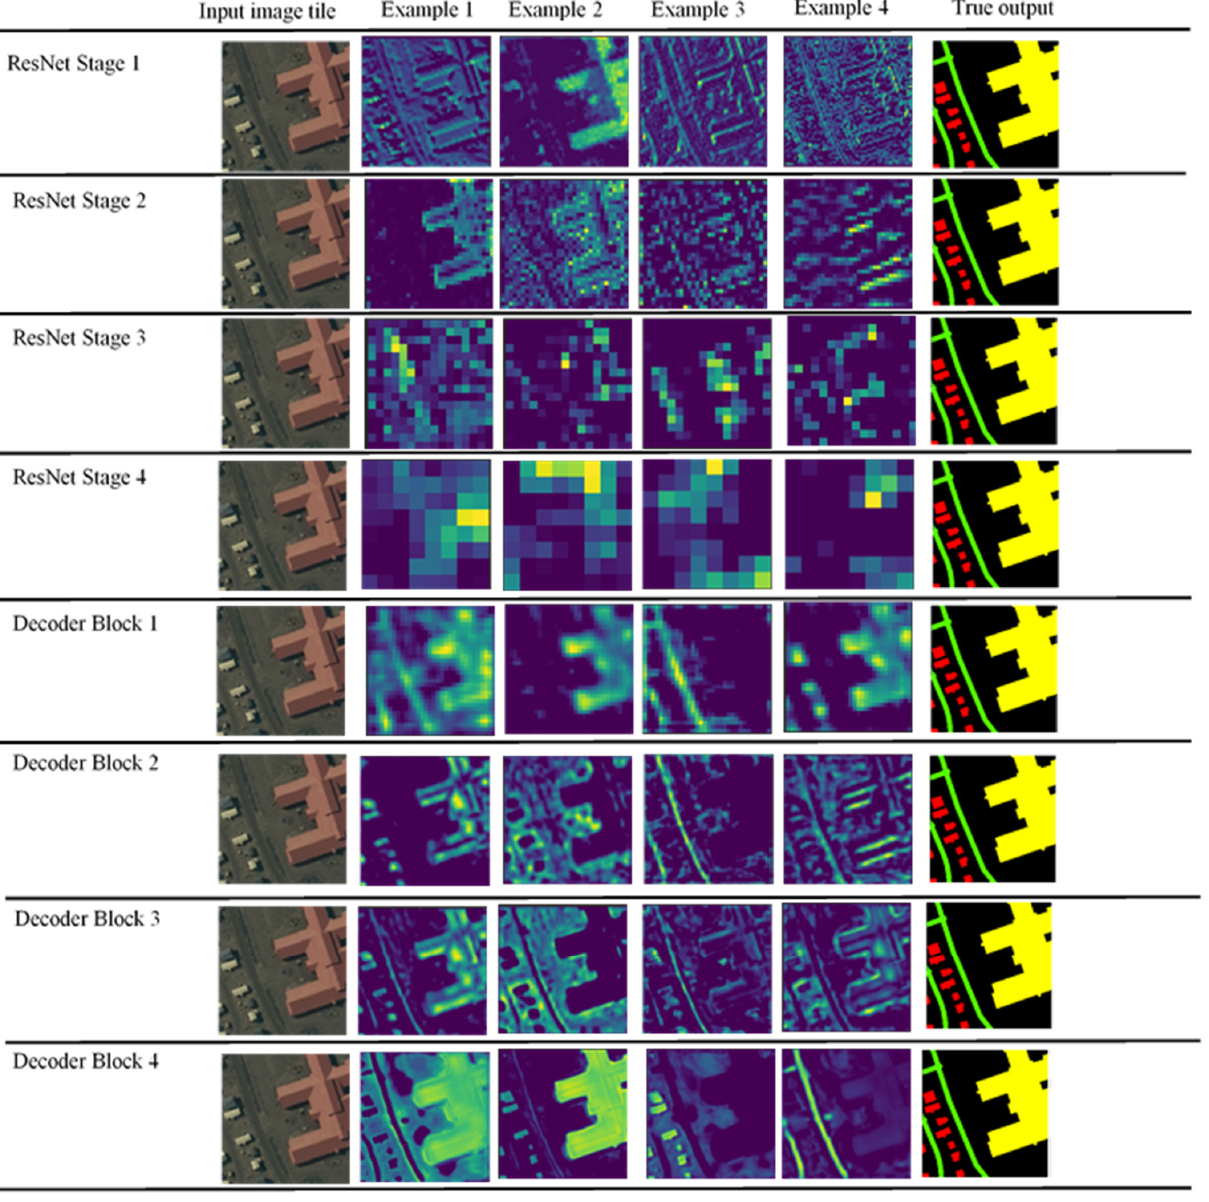
Figure 10. Four selected CFMs (Columns 2–5) from the final layer of each ResNet-50 backbone stage and decoder block. First column contains the input image tile, and final column contains the true output. Each feature map visualizes features learned by the model in detection of public buildings and roads. Imagery © DigitalGlobe, Inc.